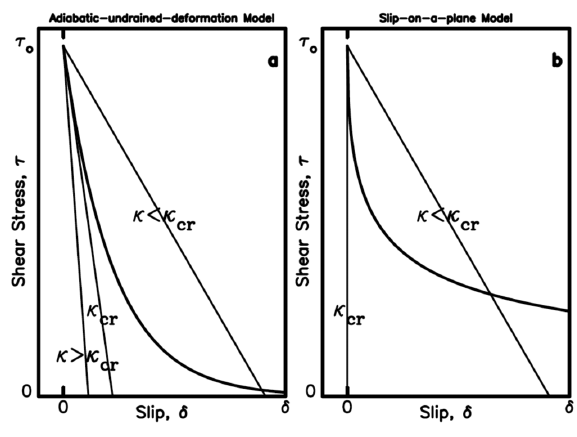
Figure 1. The functions of shear stress, x , in terms of slip, d : curves versus d : and lines for x for x f tive shear